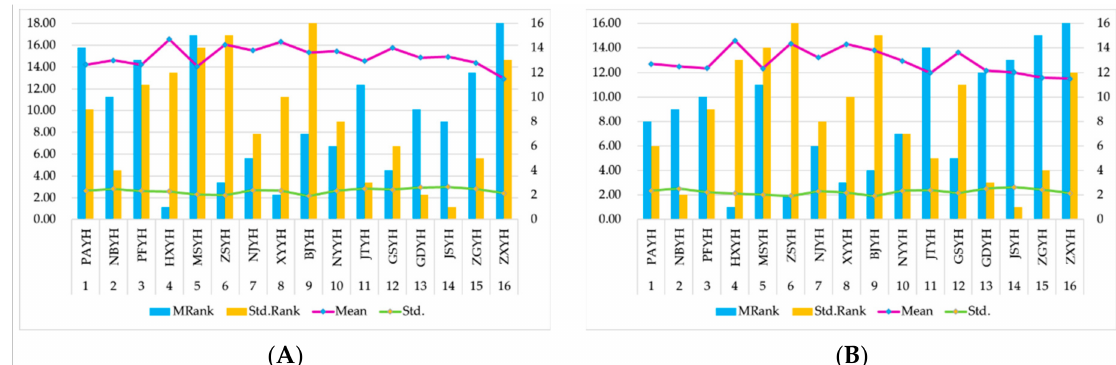
Figure 7. The results (The left axis refers to the values of the mean and standard deviation of each bank’s ∆ CoVaR, and the right axis refers to the rankings of the bank in terms of the mean and standard deviation of ∆ CoVaR. We use the same formation from Figure 7 to Figure 11) of the mean and standard deviations of ∆ CoVaR (In the figure, we calculate the daily ∆ CoVaR (the di ff erence between the Conditional Value at Risk (CoVaRs) when the bank is in distress and in a normal state) of each bank, and then derive the corresponding mean and standard deviation for each bank): ( A ) 2011; ( B ) 2012.